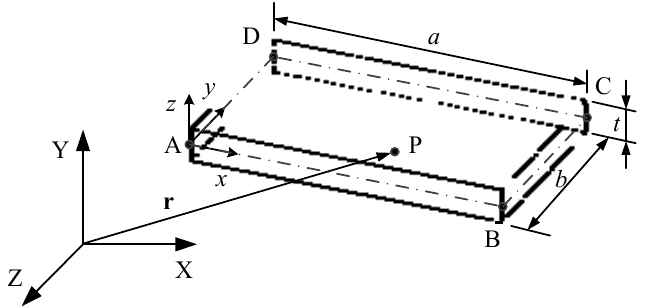
Figure 1. ANCF plate element with 3 dimensions and 4 nodes.